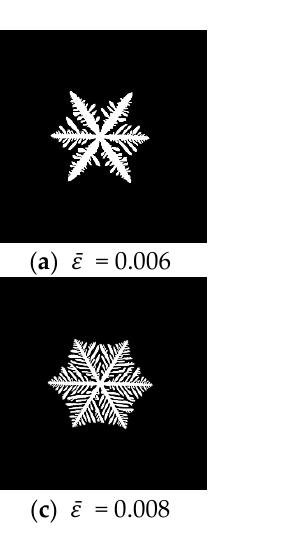
Figure 10. Morphology of snowflakes with a different ε ̄ parameter.